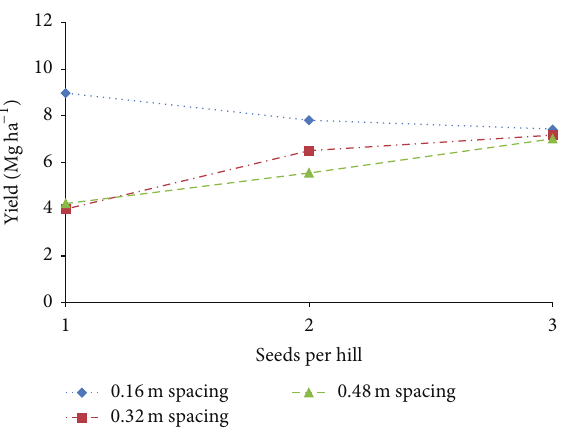
Figure 1: The interaction effects of plant spacing (0.16m, 0.32 m, and 0.48 m) and number of seeds per hill (1, 2, and 3) on grain yields (Mgha −1 ) averaged across replication at Efaw, 2012.